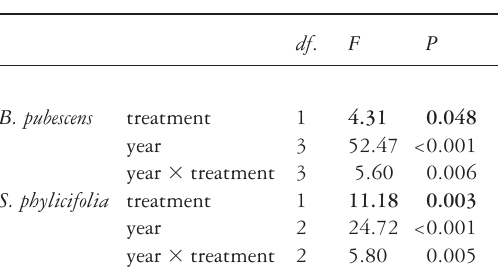
Table 1. Analysis of variance with repeated measures for differences in sapling (plants > 10 cm high) densities between browsing treatments and sampling years. Bold F and P -values indicate a significant difference between browsing treat-